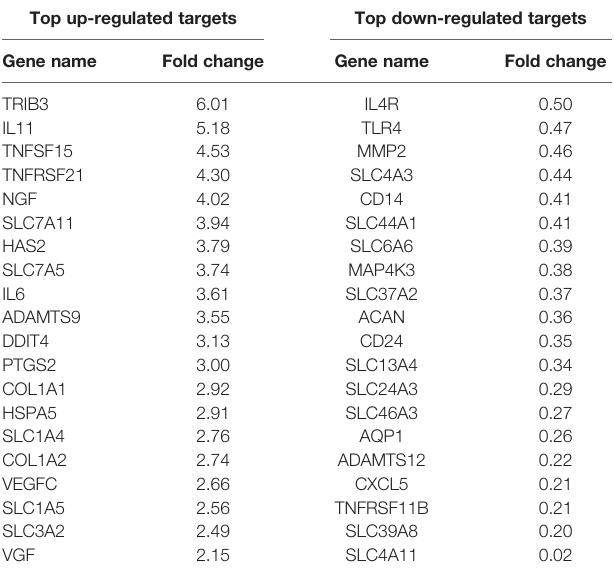
TABLE 6 | RNA sequencing: selected up- and down-regulated genes in bovine NP cells with FDR < 0.05 and p-value < 0.05 for 5 days of hypo-osmotic versus iso-osmotic treatment.